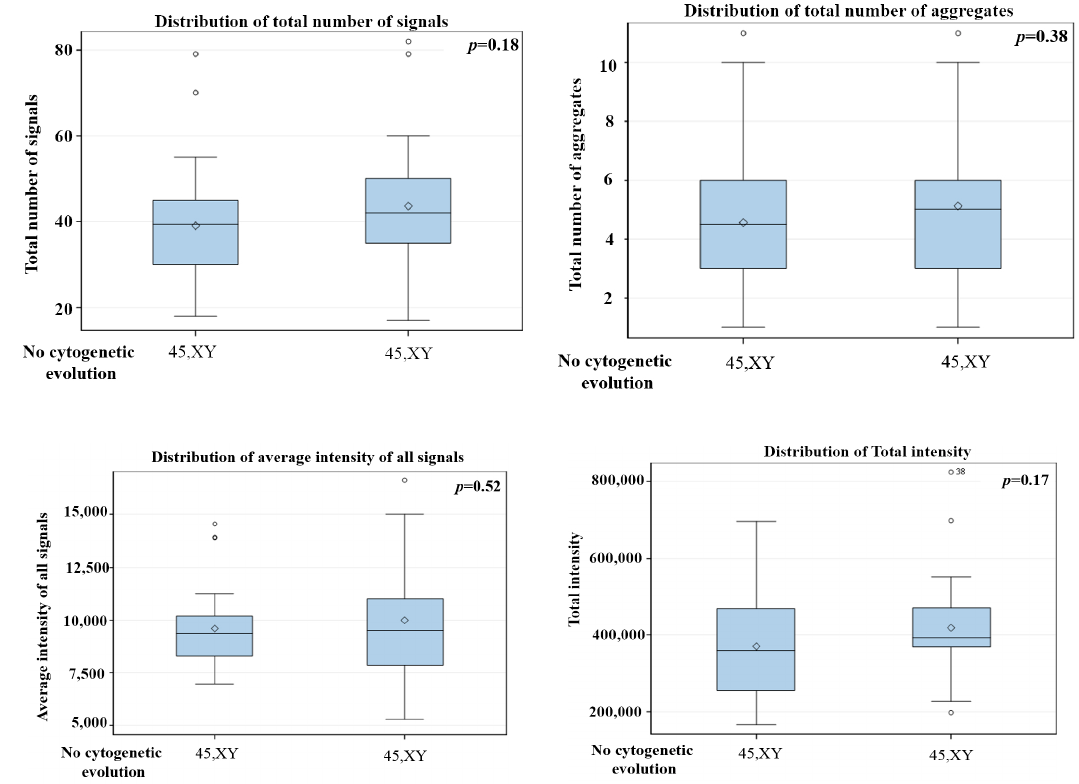
Figure 5. 3D telomere profiling during disease course in MDS without cytogenetic changes—two time points are shown after comparison of total number of signals, total number of aggregates, average intensity of signals and total intensity. The p values are in each graph, total number of aggregates, average intensity of signal and total intensity. p -values included in each graph indicate the significance when comparing the first with the last sample. (first time point with last time point collected). p -values for all other comparisons are shown in Supplementary Table S2. Patient number 9 (P9).